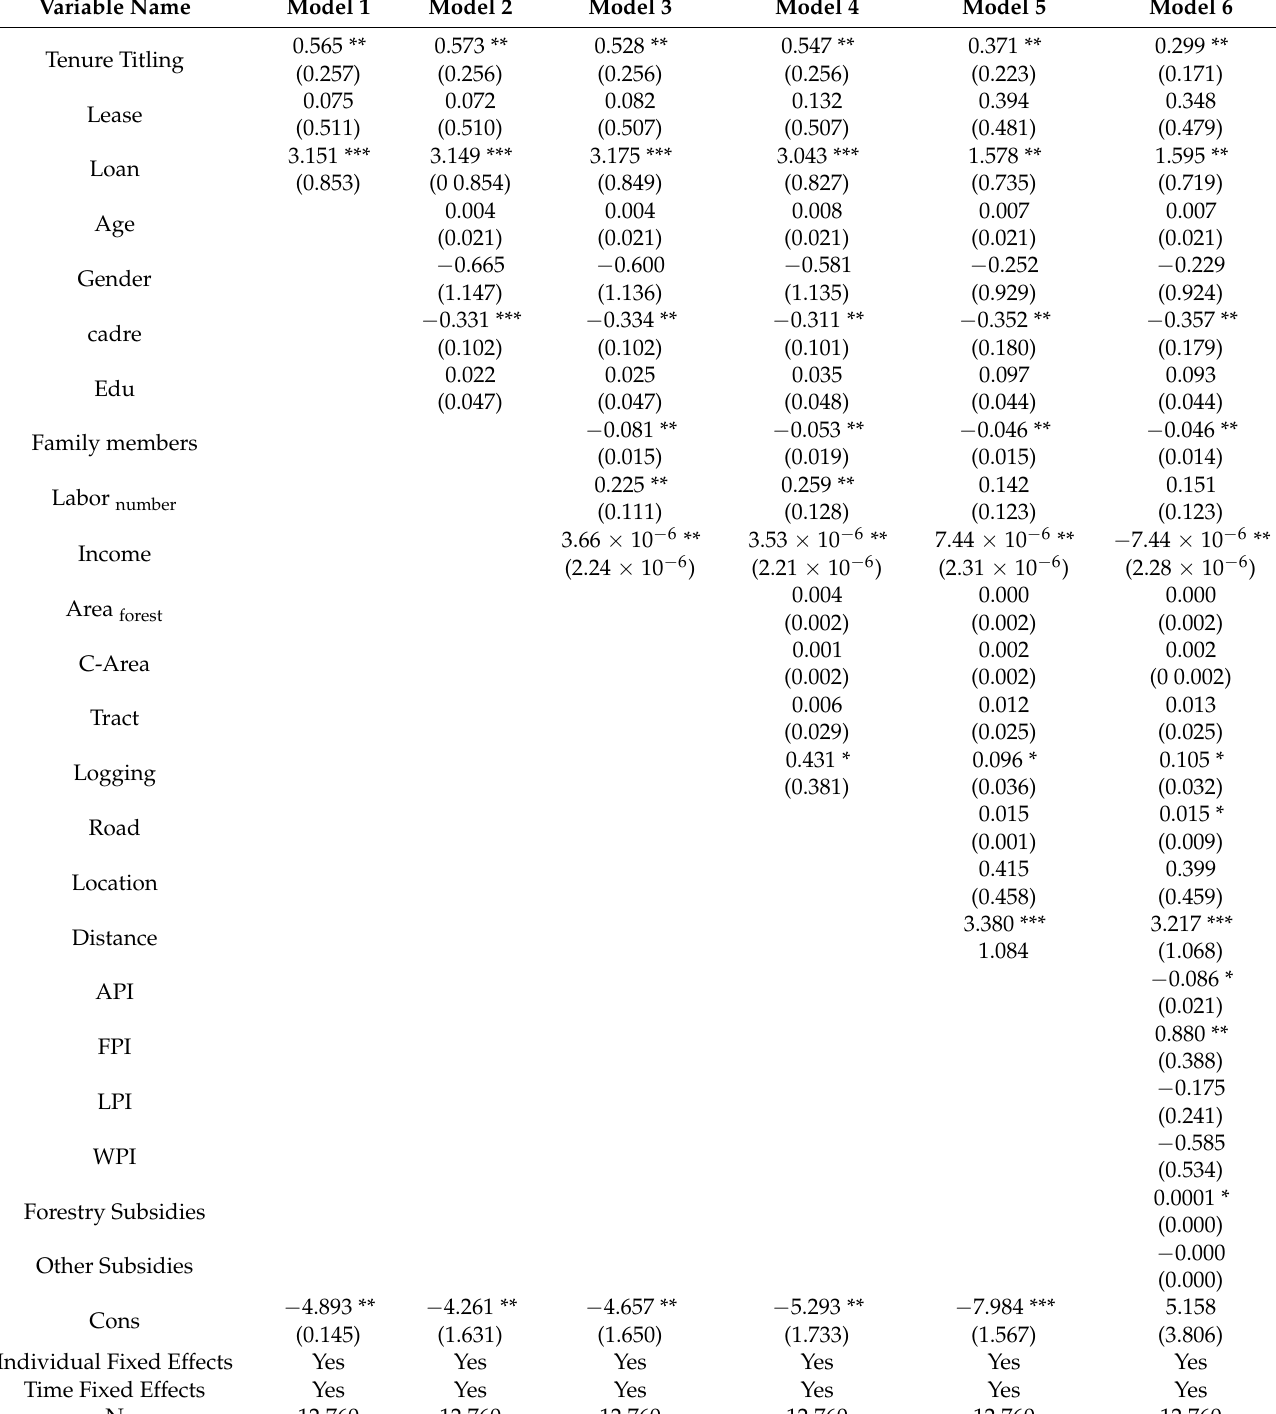
Table 2. Estimated results of household cash